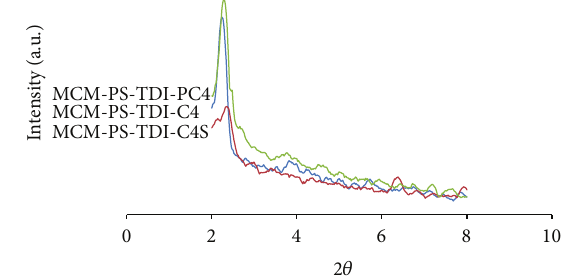
Figure 5: XRD analysis of MCM-PS-TDI-C4, MCM-PS-TDI-C4S, and